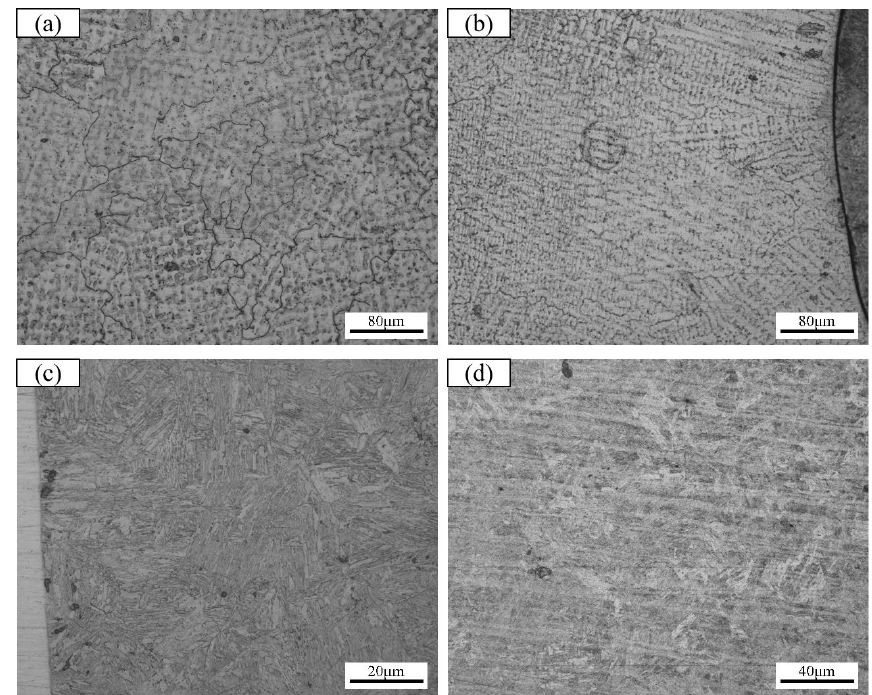
Figure 2. Metallographic structure of welded